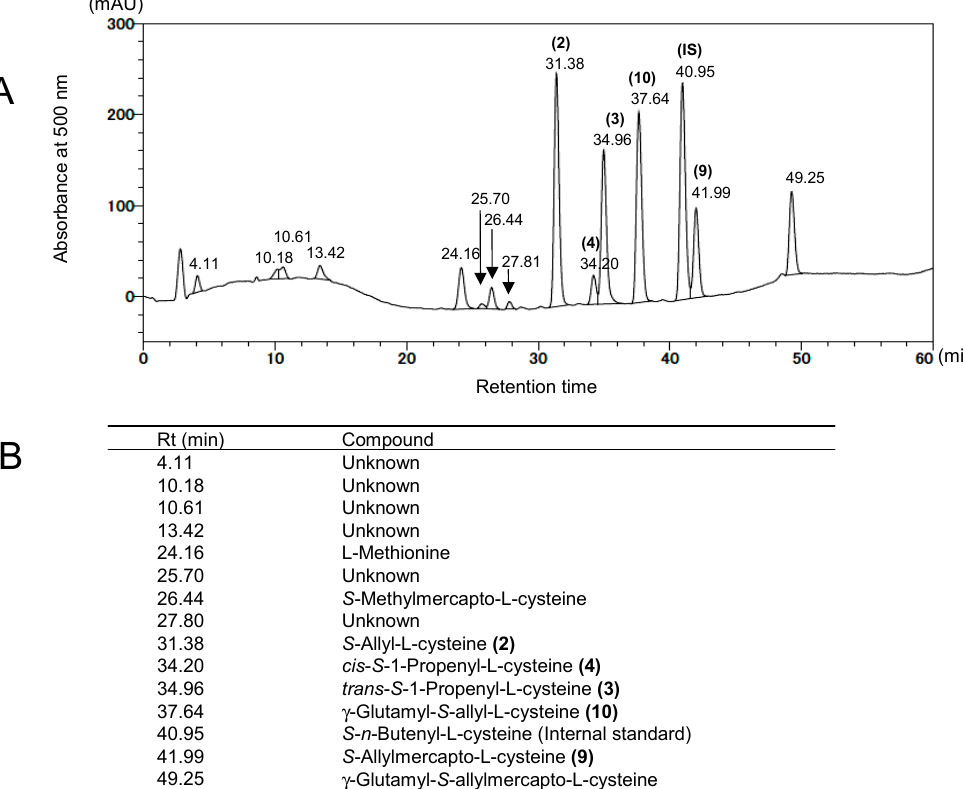
Figure 2. Chromatogram of hydrophilic sulfur compounds in aged garlic extract by sulfur specific post-column HPLC analysis using hexaiodoplatinate reagent. Chromatogram was monitored at 500 nm absorbance. HPLC analysis was performed by post-column HPLC method using a NEXERA X2 system (Shimadzu, Kyoto, Japan) according to a previous report [19]. ( A ) Chromatogram of aged garlic extract; ( B ) Identified compounds and their elution times on HPLC chromatogram. The chemical names of the numbered compounds are shown in Figure 1.